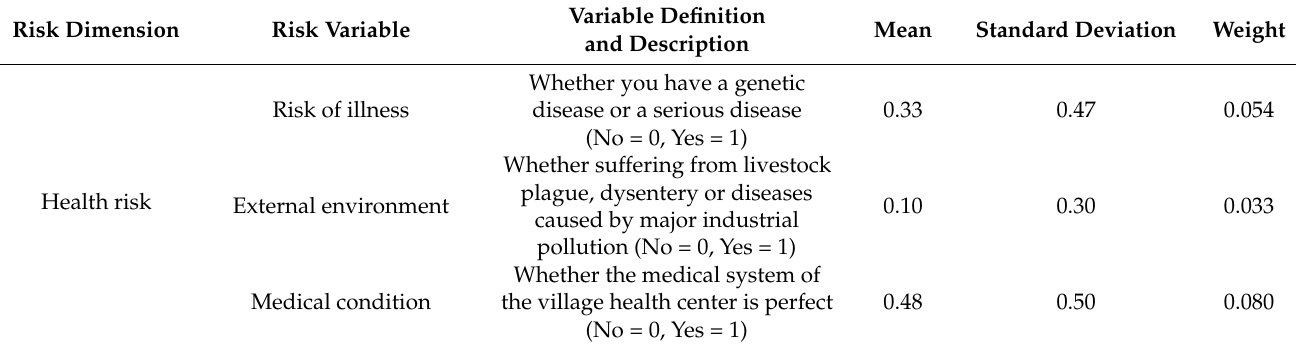
Table 1. Evaluation index system of farmer’s livelihood